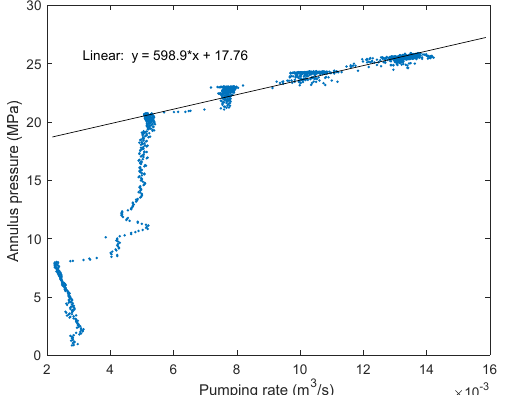
Figure 9. Annulus pressure vs. pumping rate (increasing rate) for Zone 1 Cycle 7 during the 2019 injection. One estimate of the closure pressure is the intercept of the upper linear section of the surface annulus pressure, which is 17.8 MPa. The calculated bottomhole pressure is 39.9 MPa, and the inferred stress gradient is 17.6 MPa/km.